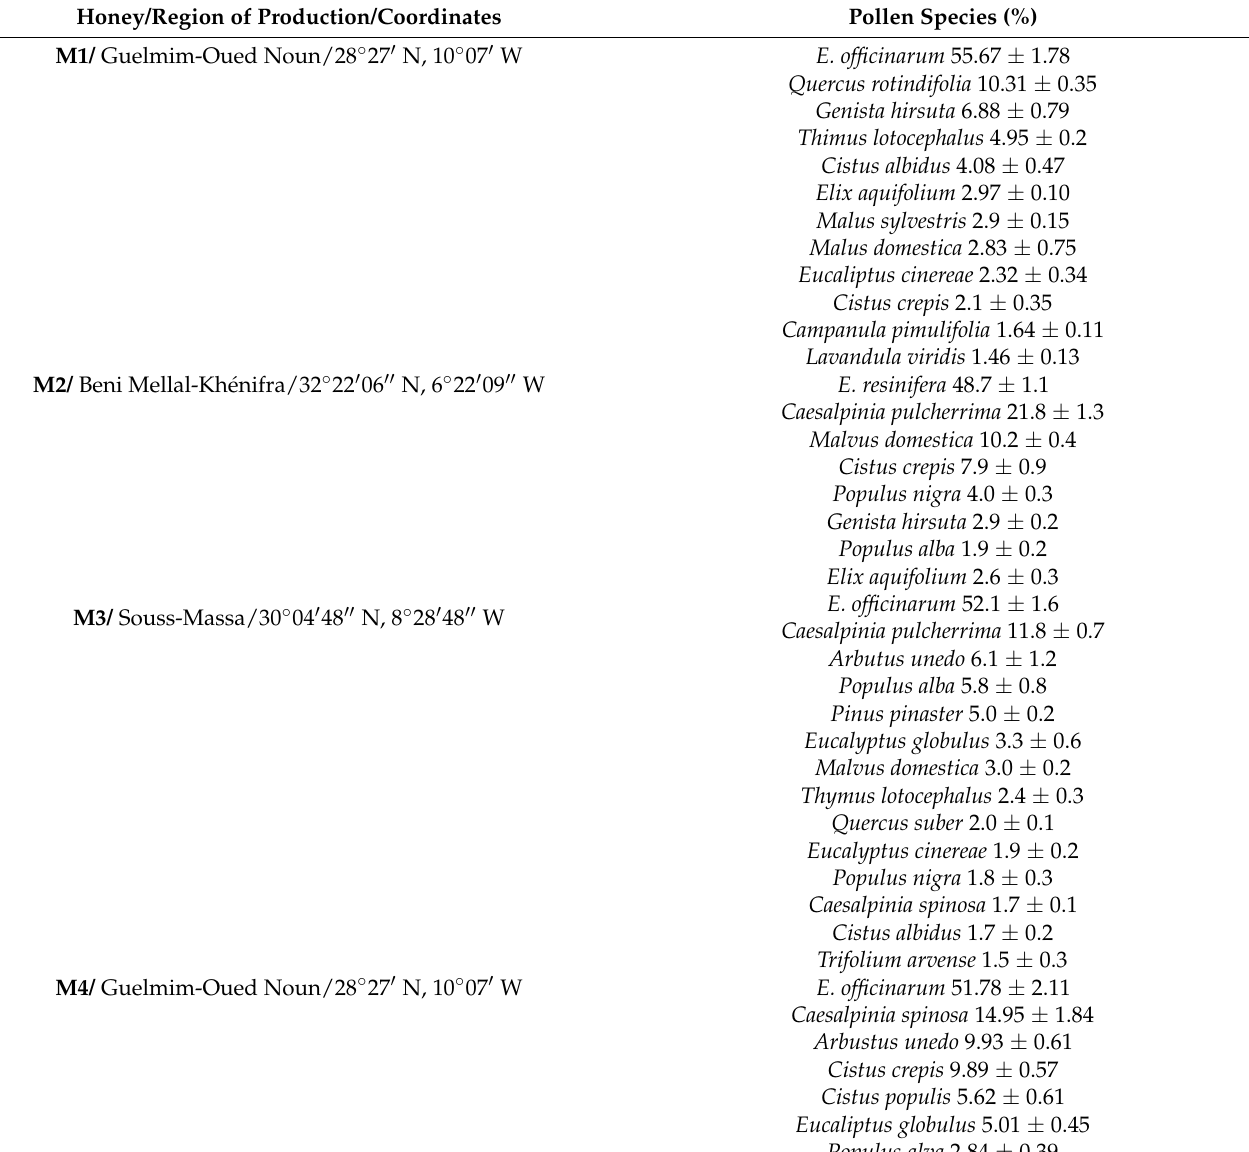
Table 1. Honey samples, place, and the most predominant pollen of seven Euphorbia honey samples from Morocco. The results of M2 and M3 samples were previously published [13]. Reproduced with permission from Oumaima Boutoub et al., Antioxidant activity and enzyme inhibitory potential of Euphorbia resinifera and E. officinarum honeys from Morocco and plant aqueous extracts; published by Springer Nature,